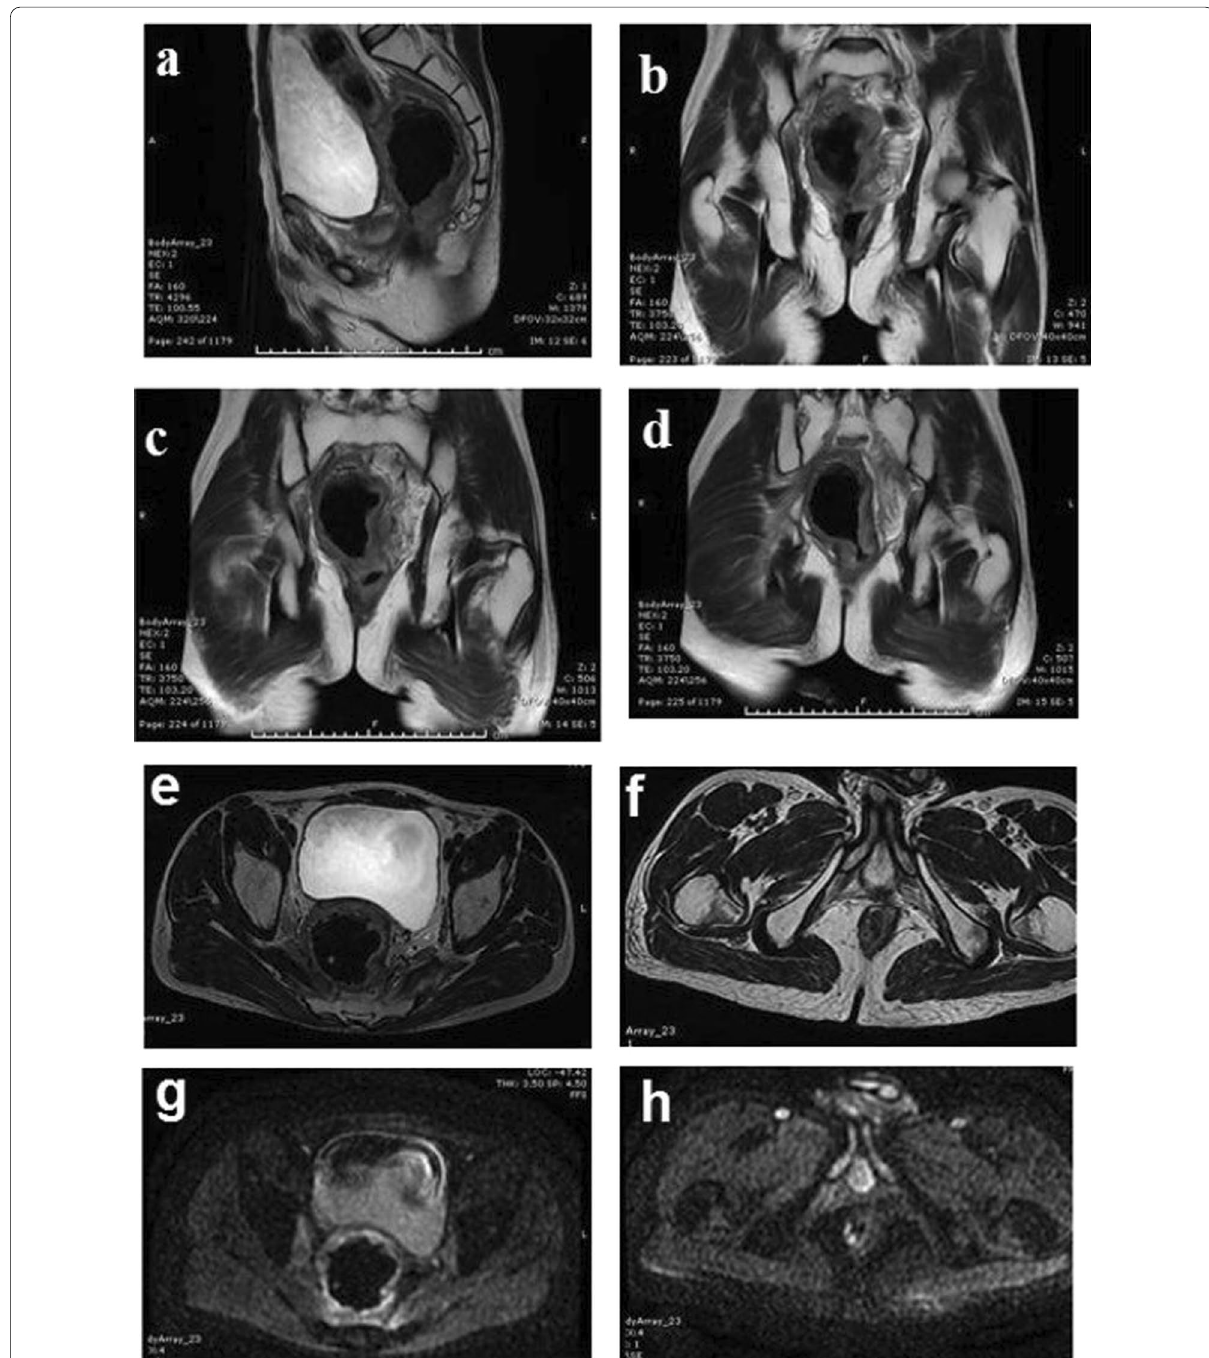
Fig. 7 a–h MRI study for a 30-year-old male with rectal adenocarcinoma of the rectum and received CRT . a–d Sagittal, Coronal and e–f axial T2 WIs (g-h) DWIs revealed: Irregular circumferential mural thickening of the middle and lower rectum is seen reaching maximum thickness of 2.7 cm and extending for 7.6 cm in length, it start 3.8 cm from the anal verge, the mass lesion is seen infiltrating the right aspect of meso-rectal fascia, it elicits intermediate T2 SI with free diffusion. Subtle focus of hyperintense signal on DWIs was noticed at the end of anal canal but not reported as a significant